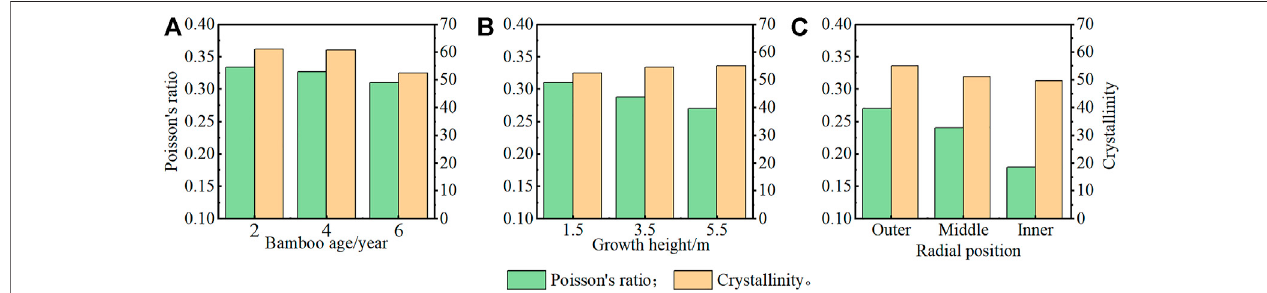
FIGURE 6 | Relationship between bamboo Poisson ’ s ratio and crystallinity: (A) Bamboo age; (B) Height; (C) Radial position.